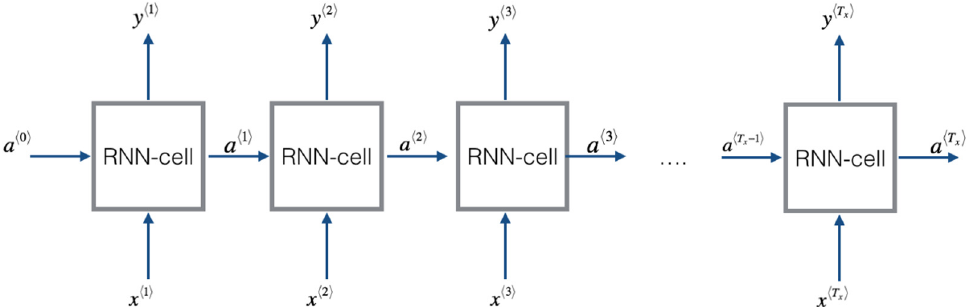
Figure 2. RNN Structure .